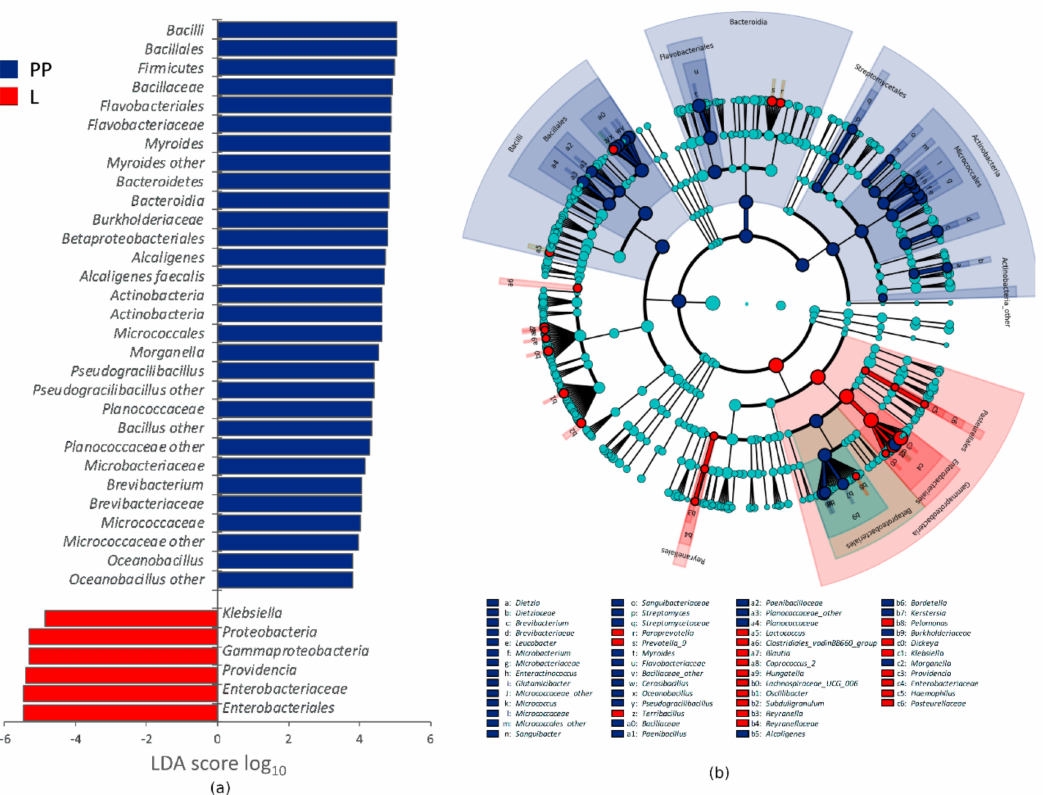
Figure 3. Linear discriminant analysis E ff ect Size (LEfSe) analysis of taxonomic features di ff erentiating L ( n = 2) and PP ( n = 6), regardless of the growth temperature: ( a ) LDA logarithmic scores of taxonomic biomarkers exhibiting significant di ff erential abundance ( p < 0.05, logarithmic LDA logarithmic score ≥ 2.0) and appearing at least once with abundance > 2.0%; ( b ) cladogram of all the taxonomic